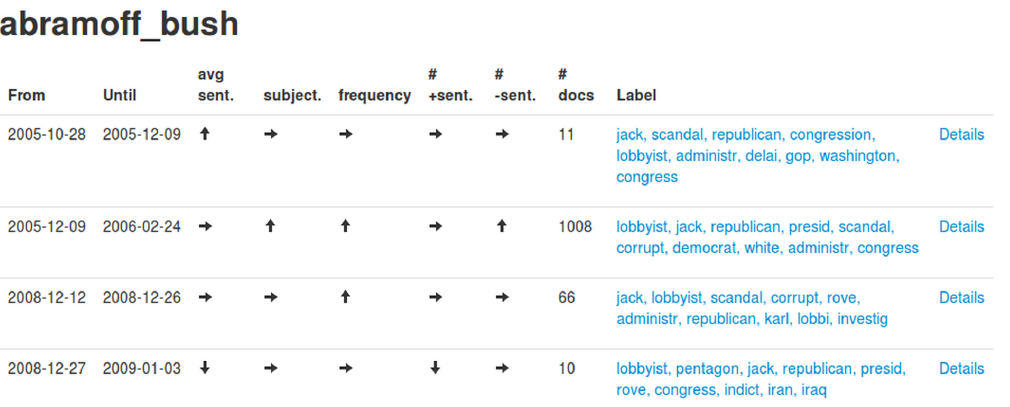
Figure 6. Screenshot of evaluation interface showing one extracted event for the entity “ariel sharon” as well as some timelines and related documents. Elements of the interface